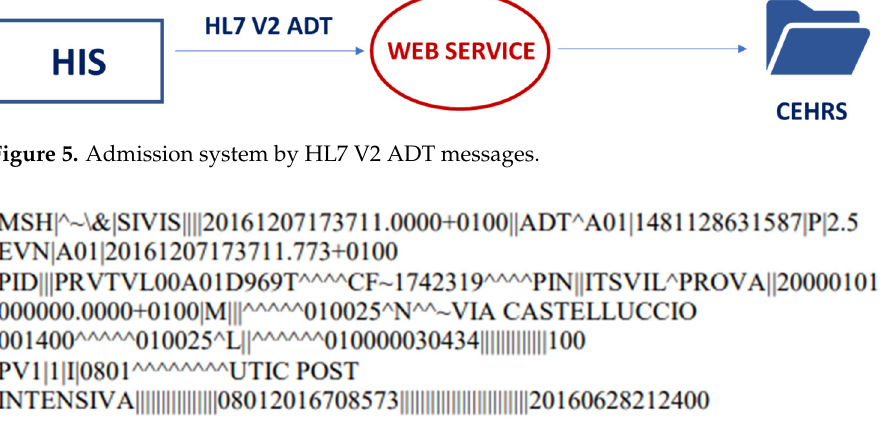
Figure 6. ADT message used in the integration shown in Figure 4 (SIVIS—mentioned in the message—is the local name for HIS).